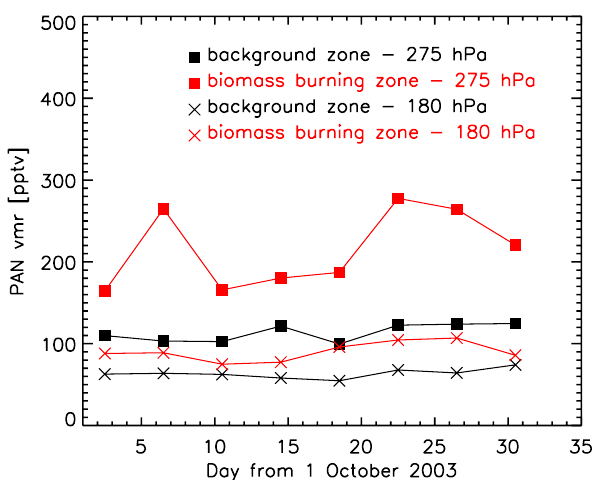
Fig. 11. 4-Daily averages on PAN amounts measured in the region 0 to 30 ◦ S, 60 ◦ W to 135 ◦ E (biomass burning zone) and 0 to 30 ◦ S, 90 to 180 ◦ W (South Pacific background zone) for the month of October 2003. The regions were chosen based on those of Glatthor et al. (2007), Fig. 9, for qualitative